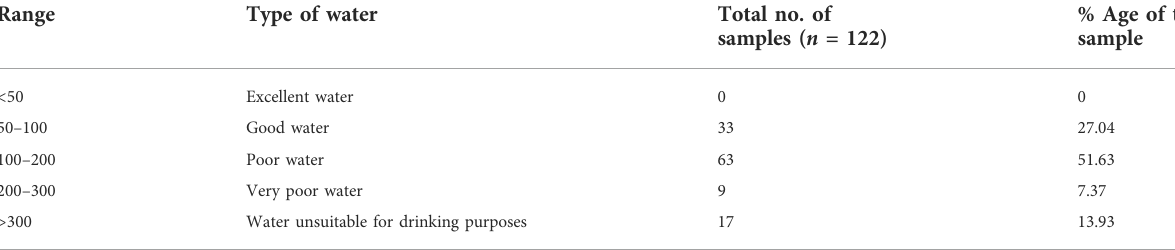
TABLE 7 Water quality classi fi cation ranges and types of water based on WQI values in the study area. Range Type of